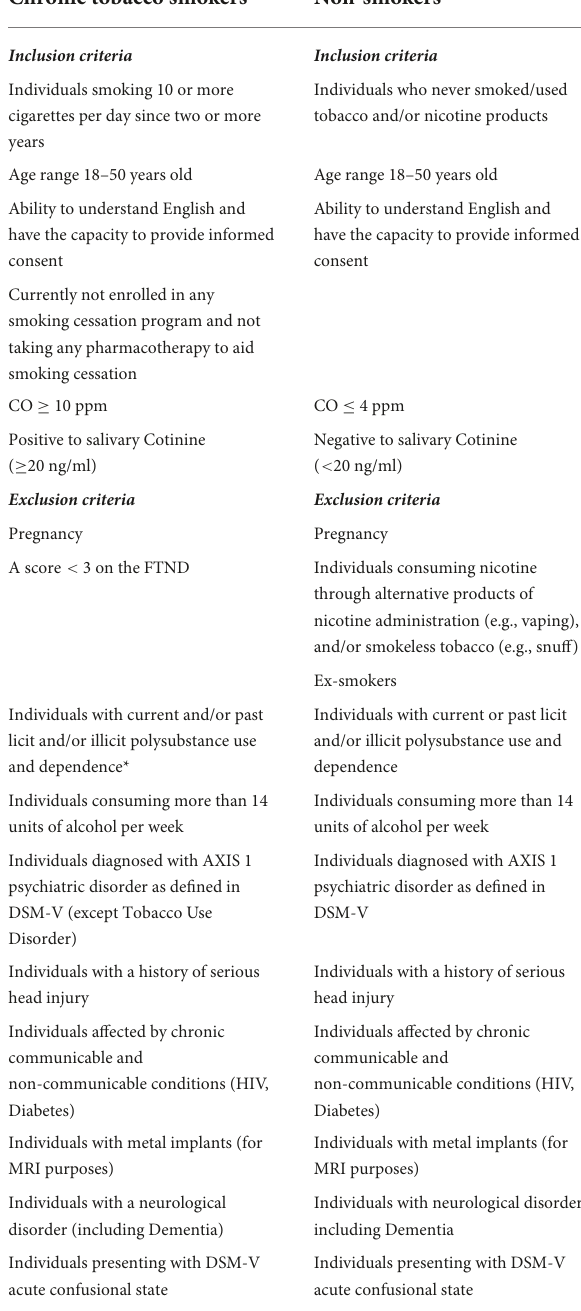
TABLE 1 Inclusion and exclusion